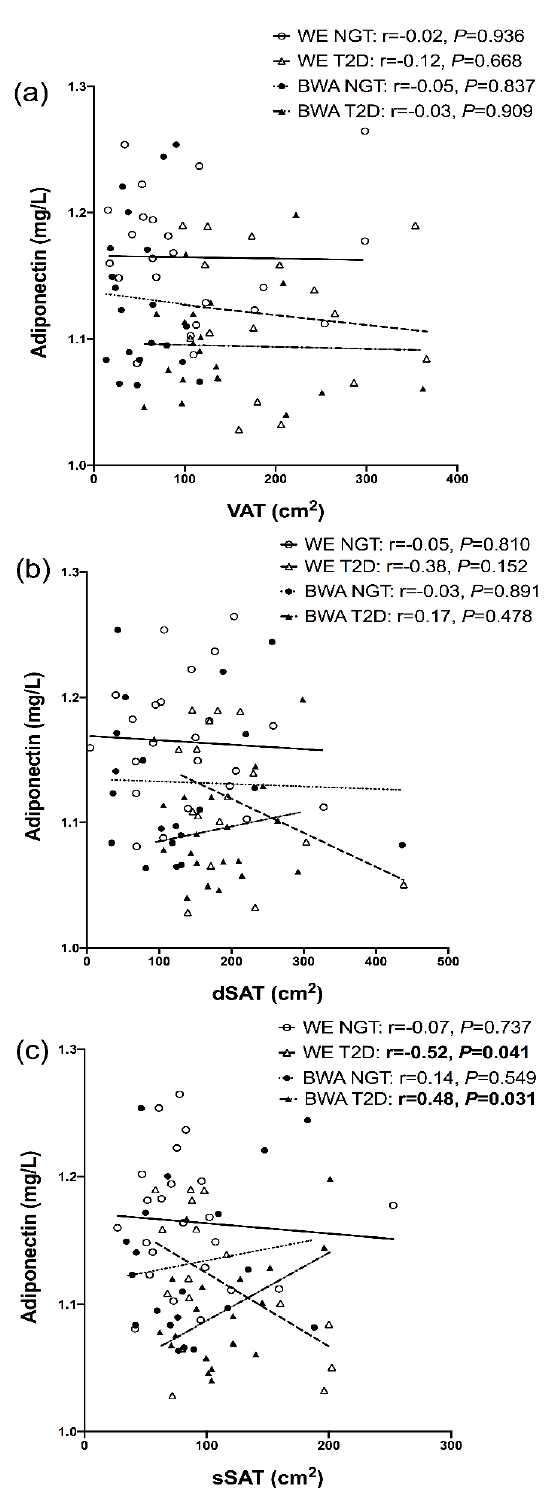
Figure 1. Relationships between adiponectin and visceral adipose tissue (VAT), ( a ), deep subcutaneous adipose tissue (dSAT), ( b ) and superficial SAT (dSAT), ( c ), in white European (WE) and black West African (BWA) men with normal glucose tolerance (NGT) and type 2 diabetes (T2D). Adiponectin underwent a + 10 then log transformation to achieve a normal distribution in the positive axis. Bold p -values indicate significance of <